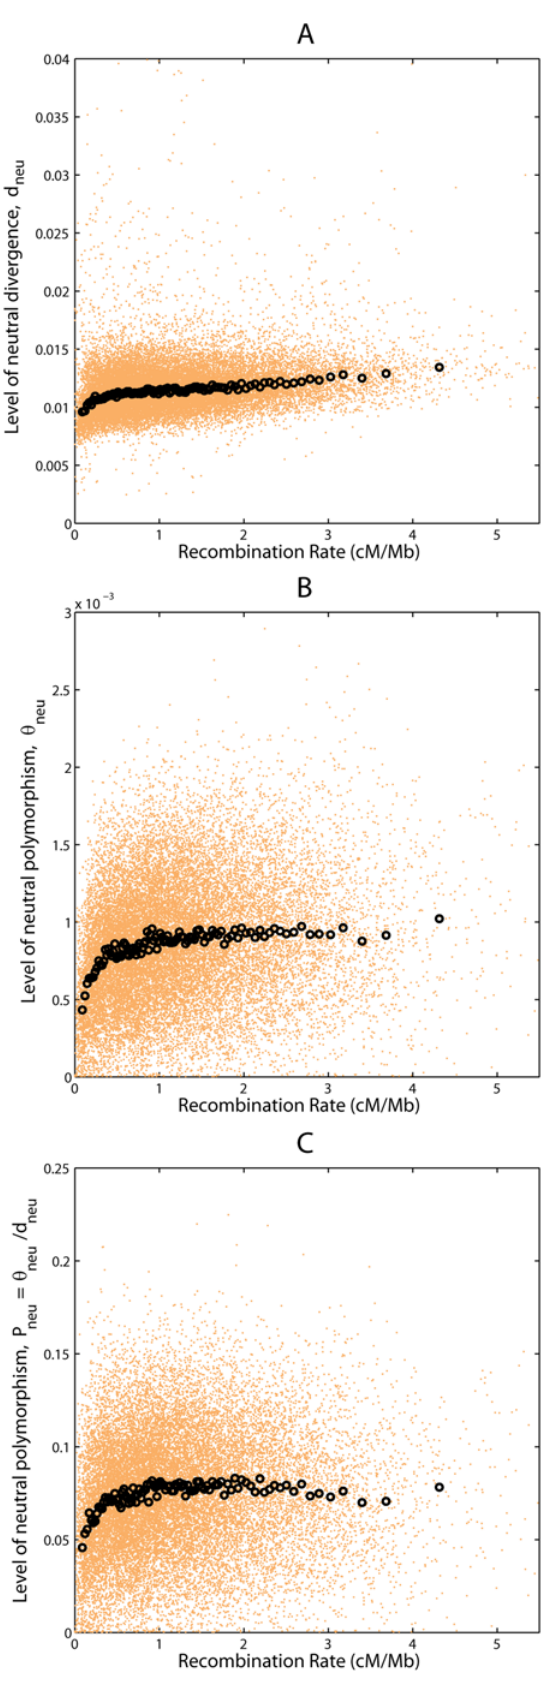
Figure 1. Correlations between recombination rate and neutral divergence rate and neutral polymorphism. Scatter plots display values of two variables in orange dots for (A) recombination rate and the level of neutral divergence rate ( d neu ), (B) recombination rate and the level of neutral polymorphism ( h neu ), and (C) recombination rate and the level of normalized neutral polymorphism ( P neu = h neu / d neu ). Black circles are average values for orange dots pooled in 100 bins each containing 1% of the data